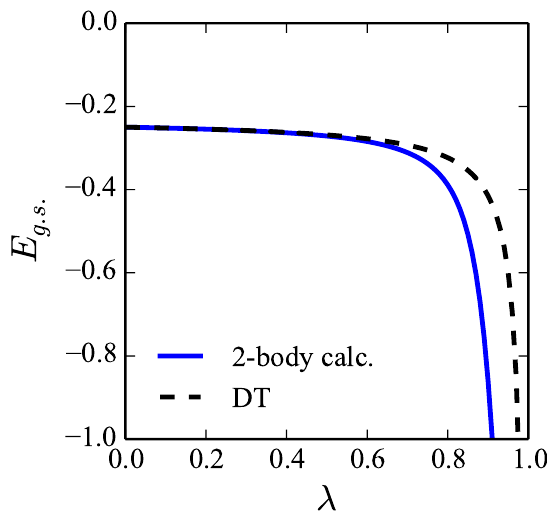
Figure 2: Comparison of the two-body ground-state energy, E full two-body calculation and the DT